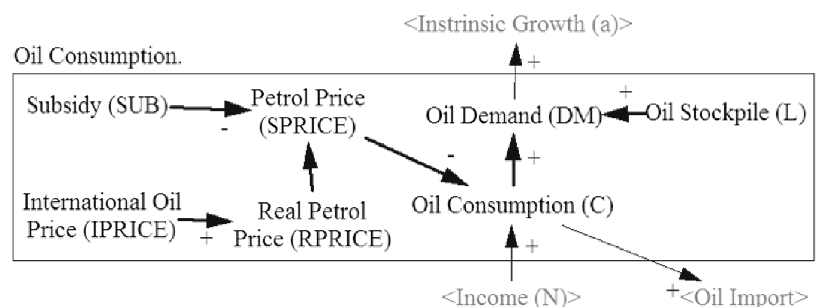
Figure 6. Oil consumption